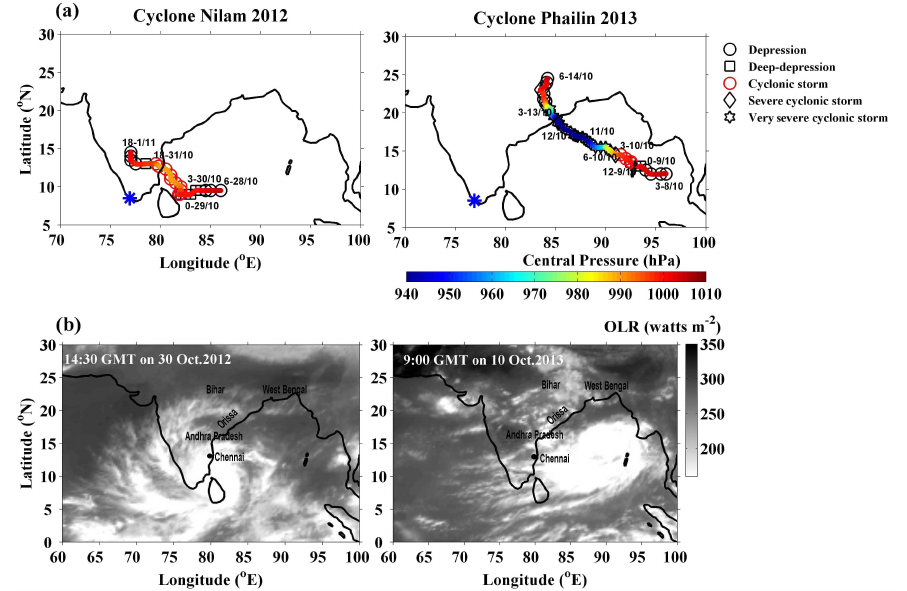
Figure 1. (a) Track of cyclones Nilam and Phailin (top panels) and (b) its outgoing long-wave radiation (OLR) wave radiation at 14:30GMT on 30 October 2012 (Nilam) and 09:00GMT on 10 October 2013 (Phailin). In each panel, date and time are mentioned along the track. In the first panel, 18-1/11 indicates 18:00GMT of 1 November 2012 and similarly followed for others. The blue star in (a) indicates the ozonesonde launching site